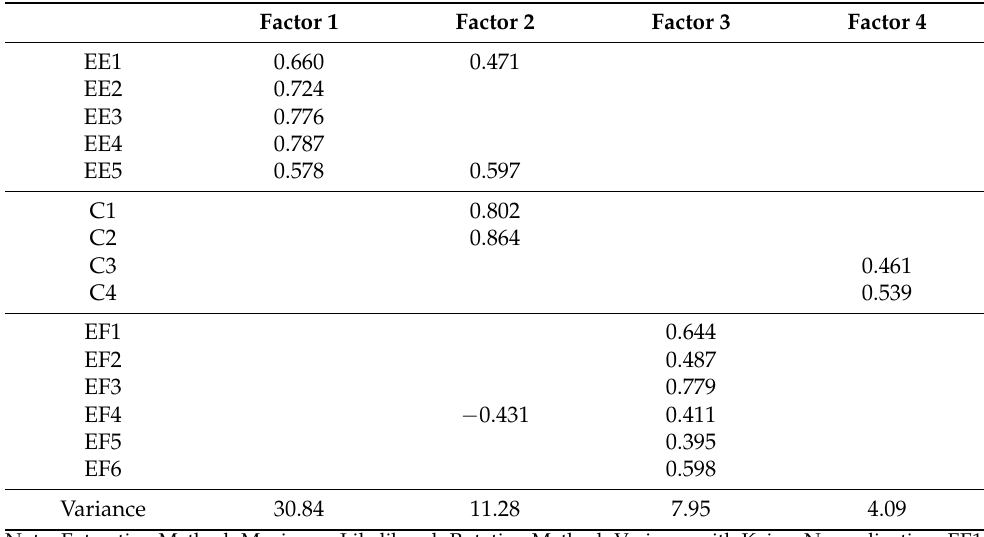
Table 7. EFA result on the MBI-GS questionnaire and percentage of variance explained by each